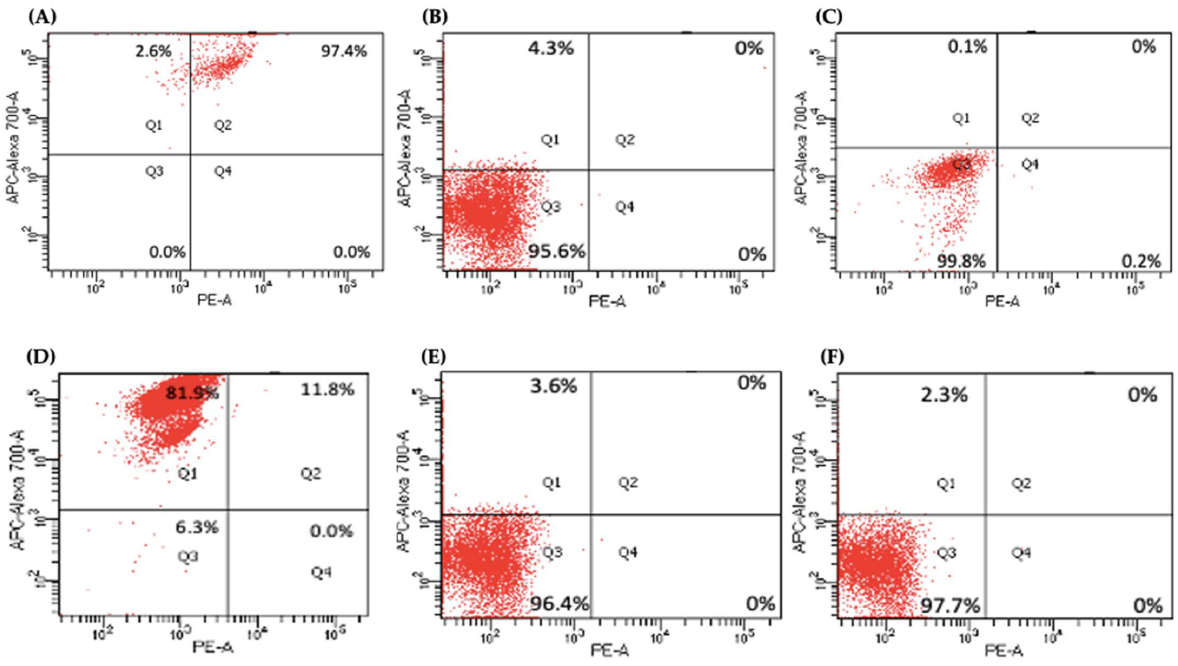
Figure 6. Flow cytometry analysis of CD24 and CD13 in miR-21 KO cell lines. ( A – C ) Expression of CD13 and CD24 in the Panc-1 KOs: ( A ) Panc-1 vector alone (control cells); ( B ) miR-21 KO2; ( C ) miR-21